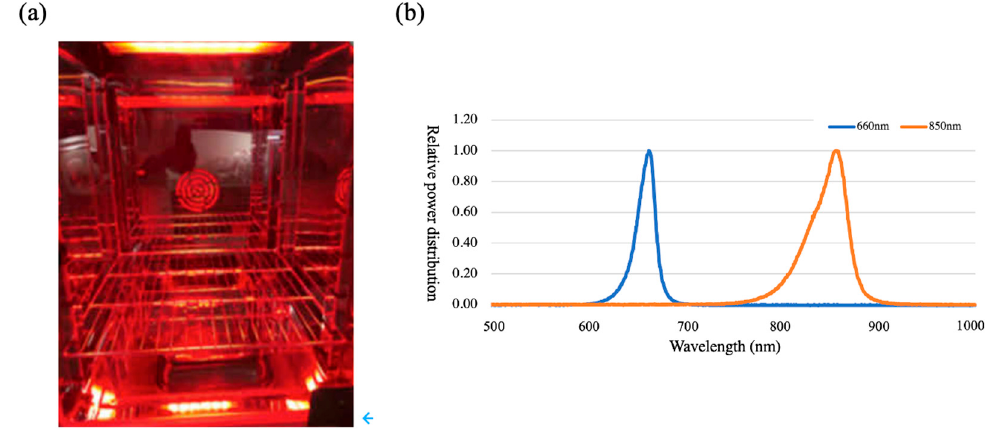
Figure 2. Light-humidified incubator and spectrum of the respective LED light source. ( a ) Light humidified incubator. ( b ) The spectra of red light (660 nm) and NIR light (850 nm) used in this study.